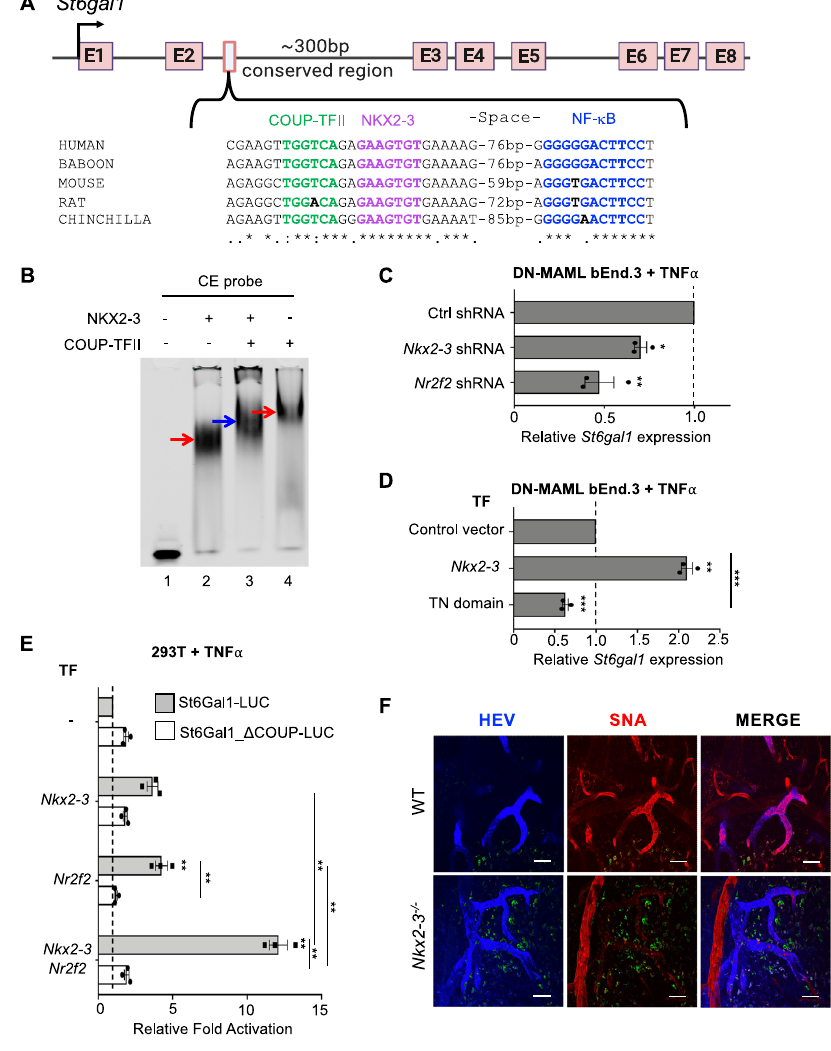
Fig. 3 | NKX2-3regulates St6gal1 expressionviaa conserved NCCE.A Schematic ofthe St6gal1 geneandanNCCEinthesecondintron. B EMSAshowingmigrationof NKX2-3, COUP-TFII-GST (red arrows), and NKX2-3:COUP-TFII heterodimer (blue arrow) bound to an St6gal1 CE probe. C St6gal1 expression in DN-MAML bEnd.3 cells stably transfected with Nkx2-3 or Nr2f2 shRNA, evaluated by real-time PCR. D St6gal1 expression in DN-MAML bEnd.3 cells stably transfected with NKX2-3 or the NKX2-3 TN domain. E Activity of luciferase reporter driven by St6gal1 NCCE- containing promoter (St6Gal1-LUC; gray bars) or St6gal1 NCCE-containing